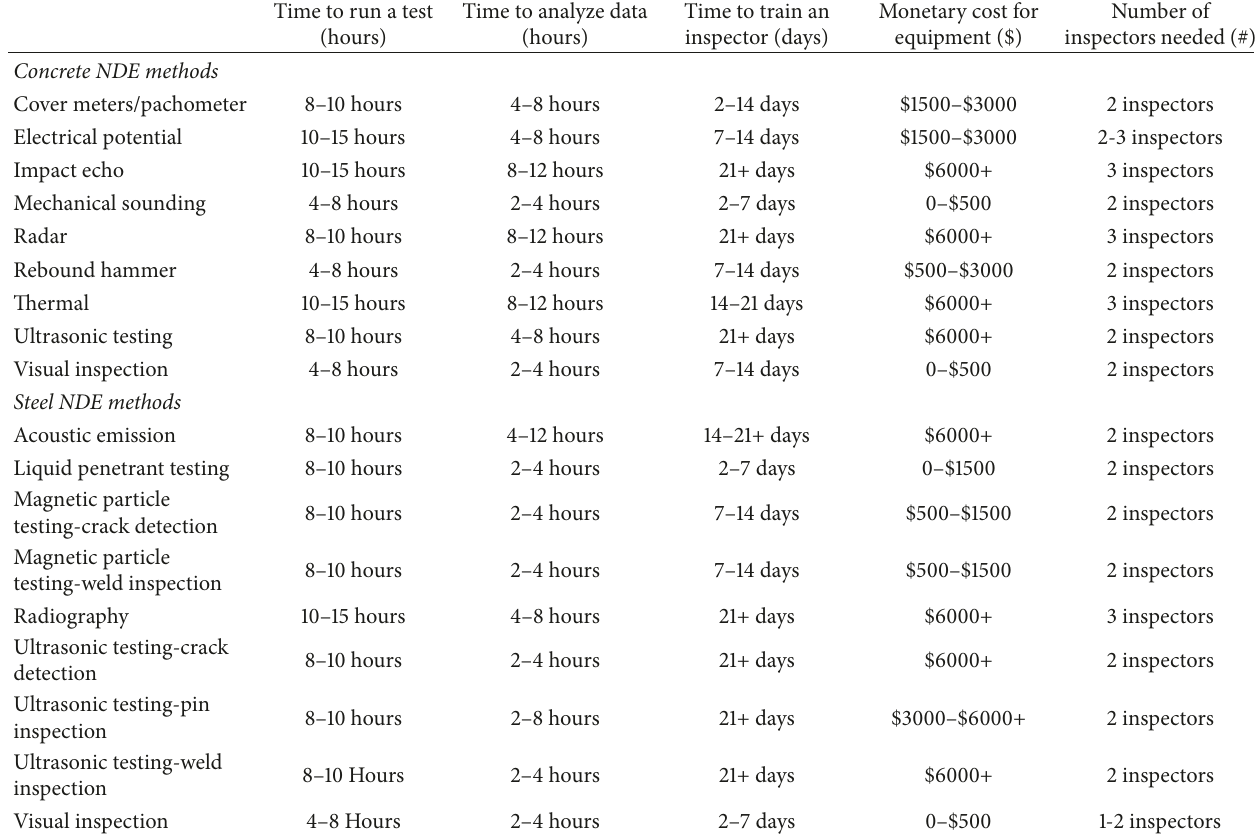
Table 7: Concrete and Steel NDE method cost ranges as indicated by participant